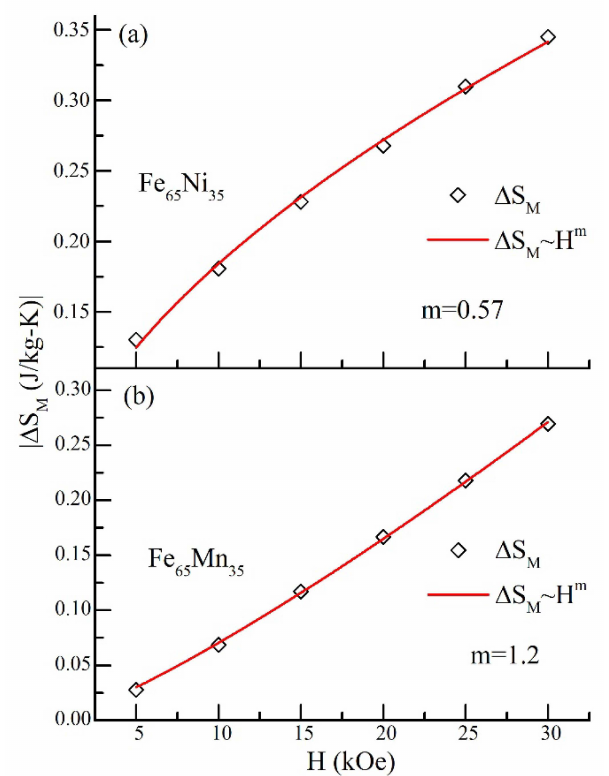
Figure 6. Field response of isothermal magnetic entropy change ( ∆ S M ) at maximum entropy tem- perature: ( a ) ∆ S M vs. H curve for Fe 65 Ni 35 ; ( b ) ∆ S M vs. H curve for Fe 65 Mn 35 . The plot through the points is fit to the power law behavior ( ∆ S M ~H m